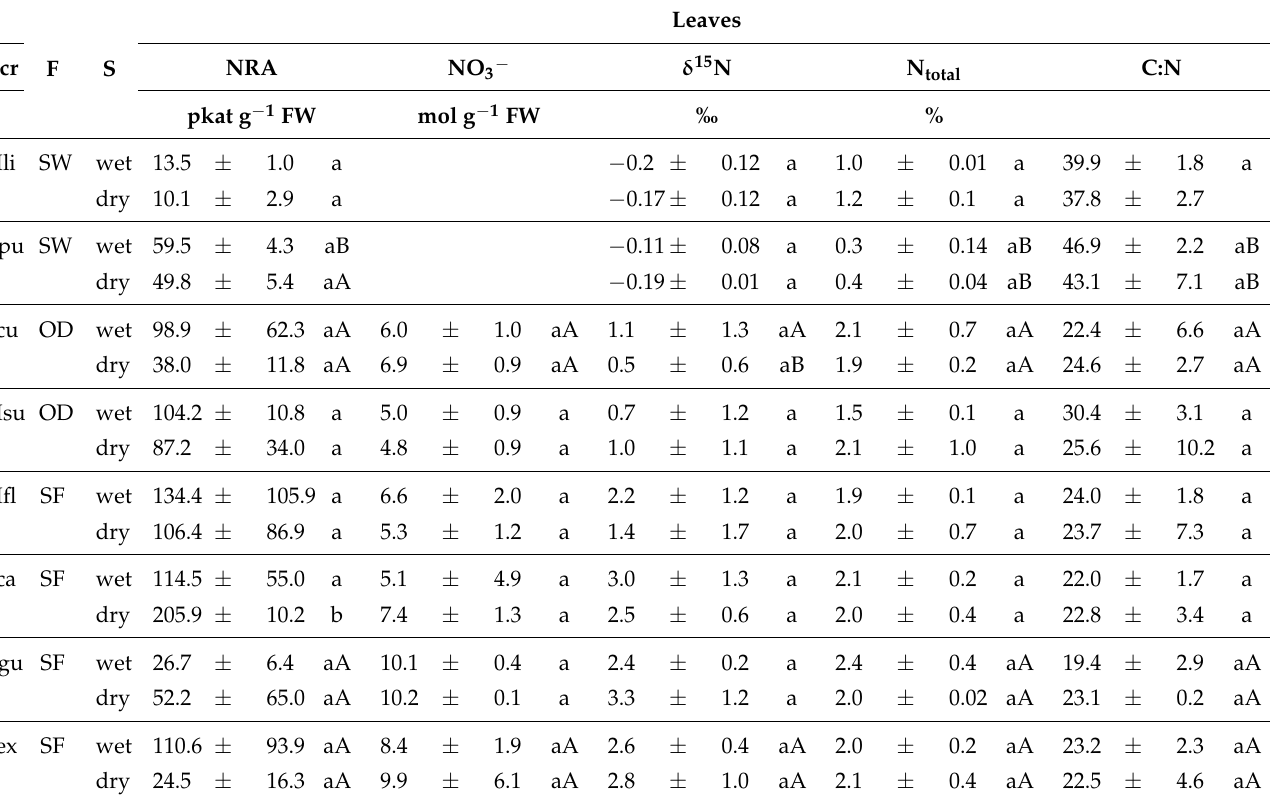
Table 3. Nitrate reductase activity (NRA), nitrate concentration (NO 3 − ), natural N abundance ( δ 15 N), total nitrogen (N total ), and carbon:nitrogen ratio (C:N) in leaves. Data are the mean ± standard error; lowercase letters indicate significant differences between seasons by species, and uppercase letters indicate significant differences between the same Myrtaceae genera for forest types (ANOVA and Tukey’s HSD post hoc test, α = 0.05). Acr—the species acronym, F—Forest type,